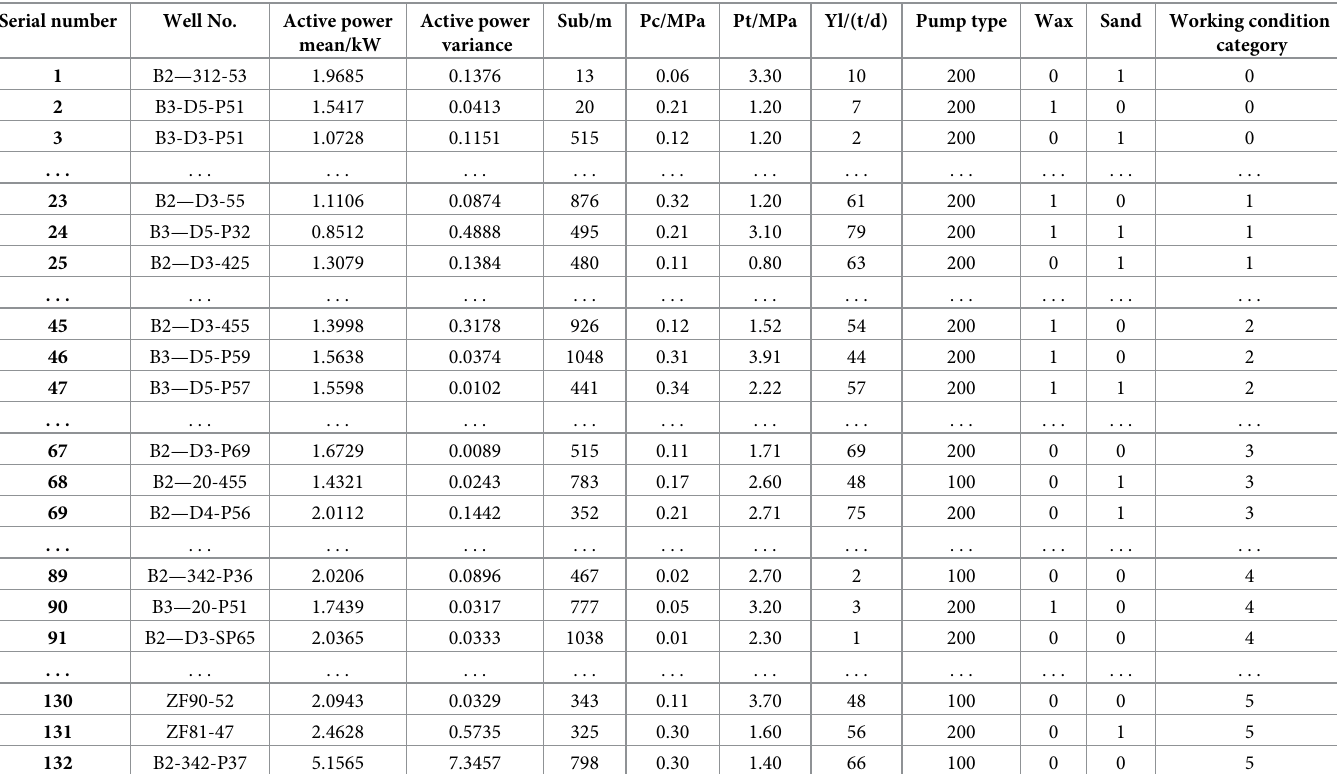
Table 2. Part of the data of the fault diagnosis model.